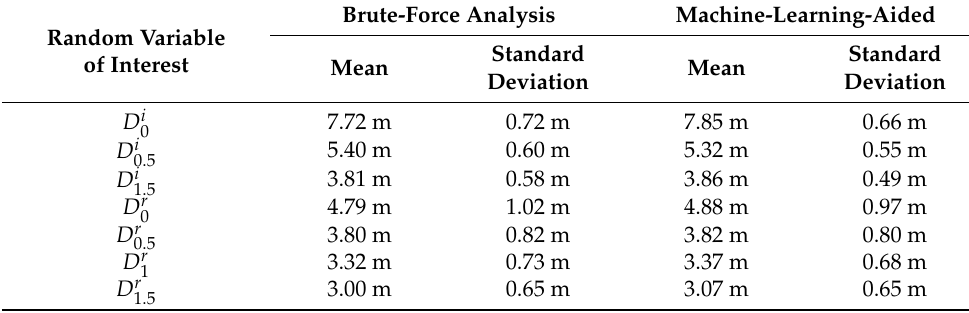
Table 4. The statistics of influence distance and